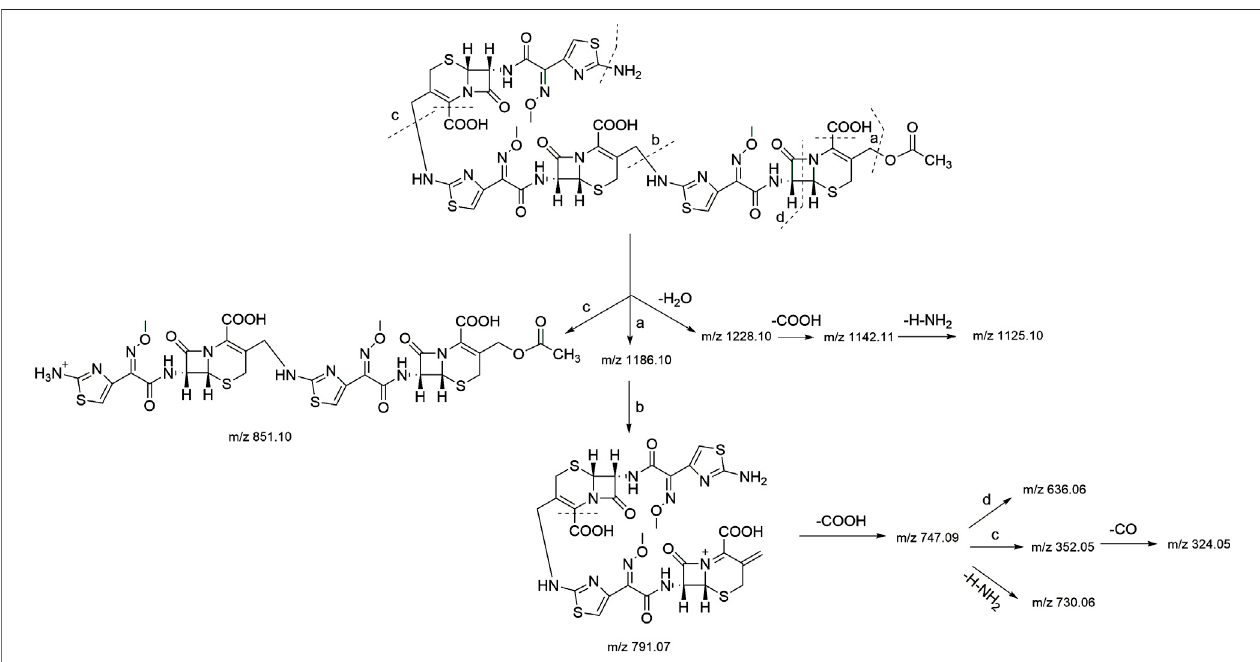
FIGURE 4 | MS fragmentation pathway of cefotaxime trimer.